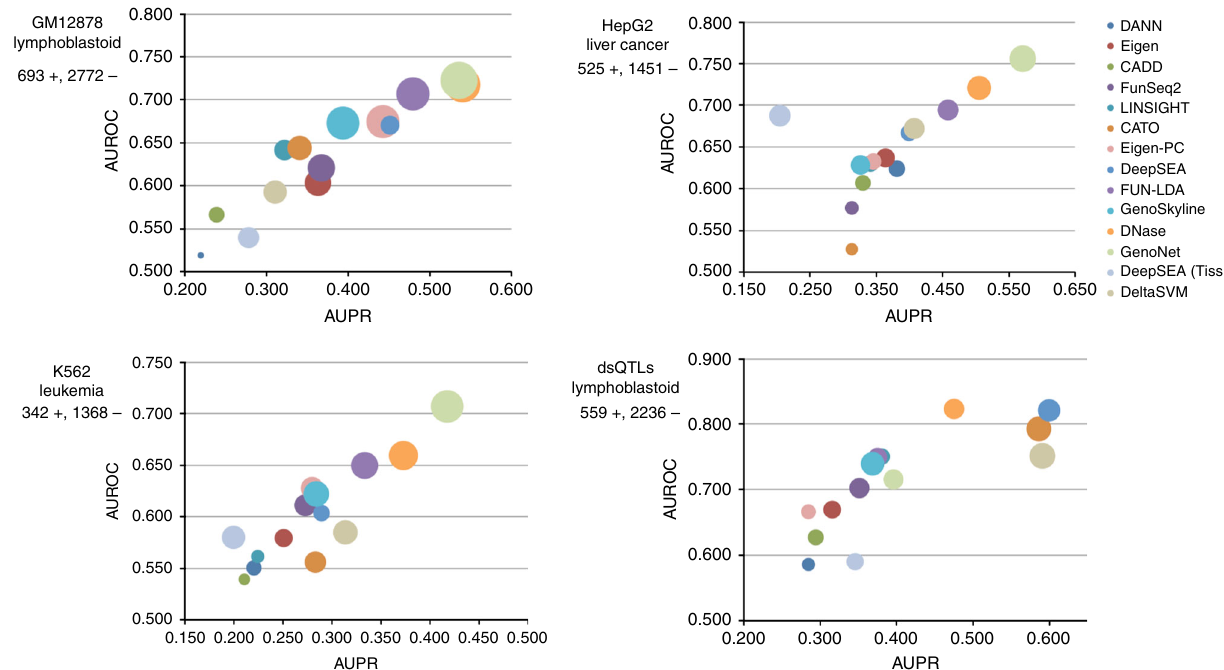
Fig. 2 Cell type/tissue-speci fi c prediction of regulatory variants. Each fi gure presents the AUPR (area under the precision recall curve), AUROC (area under the receiver operating characteristics curve), and COR (Pearson correlation between predicted and true labels). X axis presents AUPR; Y axis presents AUROC; the bubble size represents COR. GM12878: MPRA validated variants in lymphoblastoid cells (693 positive variants, 2772 control variants). HepG2: MPRA validated variants in liver carcinoma cells (525 positive variants, 1451 control variants). K562: MPRA validated variants in erythrocytic leukemia cells (342 positive variants, 1368 control variants). dsQTLs: a set of DNase I – sensitivity quantitative trait loci identi fi ed in a collection of human lymphoblastoid cell lines (559 positive variants, 2236 control variants). GenoNet: the proposed semi-supervised